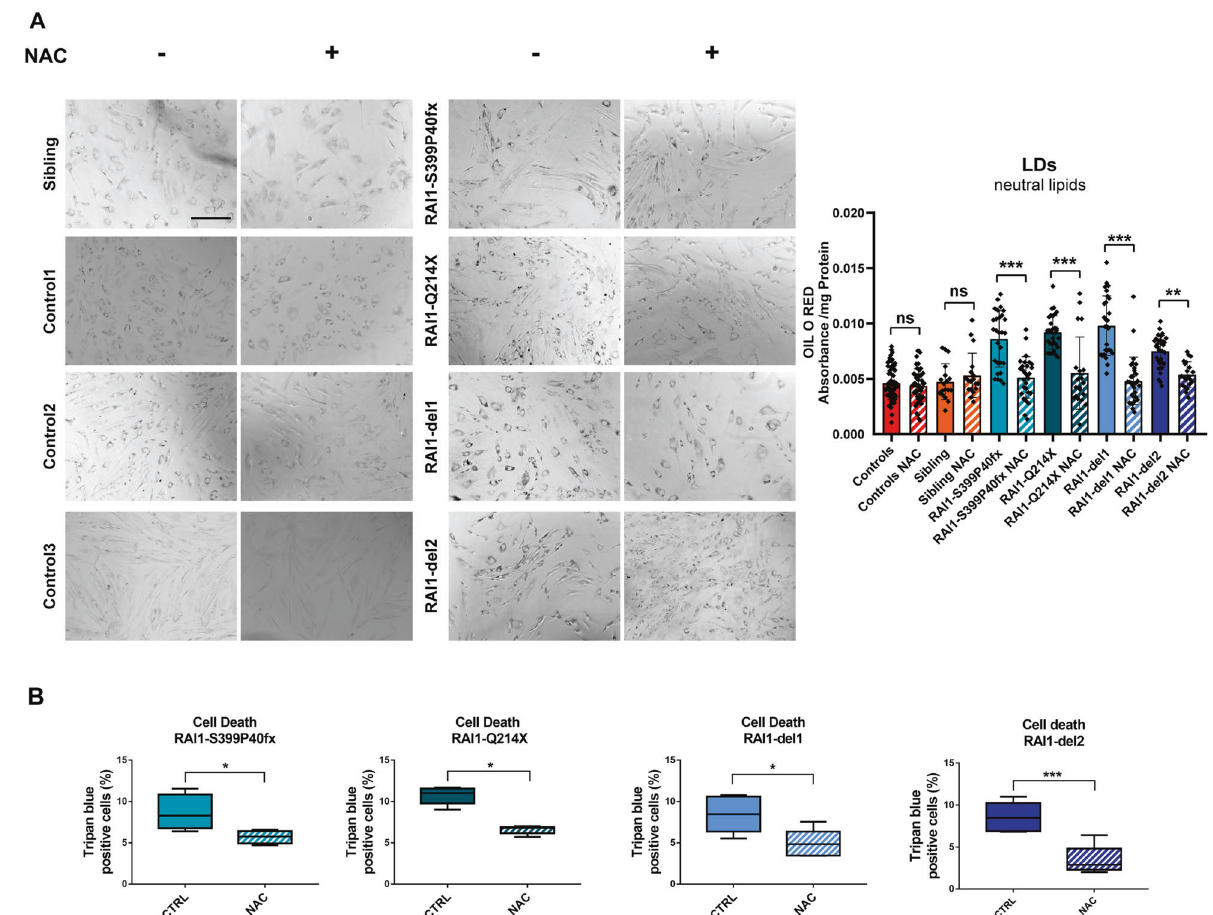
Fig. 8 N-acetylcysteine attenuates the phenotype of SMS cells. A Left panel: Representative fl uorescence microscopy images of lipid droplets (LDs) colored with Oil Red O in four SMS and four CTR cells (CTR1/2/3 and sibling) treated with N-acetylcysteine (NAC, 10 μ M, 24 h) ( n = 5 biological replicates). Right panel: Quanti fi cation of the optical density of 10 independent wells from fi ve biological replicates. B Trypan blue analysis of cell death in four SMS and four CTR cell lines (CTR1/2/3 and sibling) treated with NAC (10 μ M, 24 h) ( n = 5 biological replicates). Graphs: mean ± SEM, ( B ) one-way ANOVA + Newman – Keuls post hoc test, ( C ) unpaired t test, * p < 0.05, ** p < 0.01, *** p < 0.001, ns not signi fi